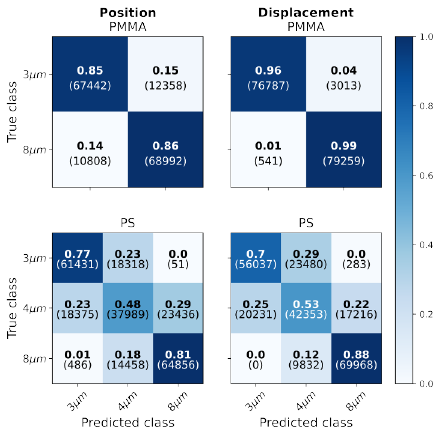
Figure 2. Confusion matrix results of classification between types of particles. Left side results using the position based his- tograms and right side using displacement based histograms. Top (bottom) row subset of 3 µ m (8 µ m ).